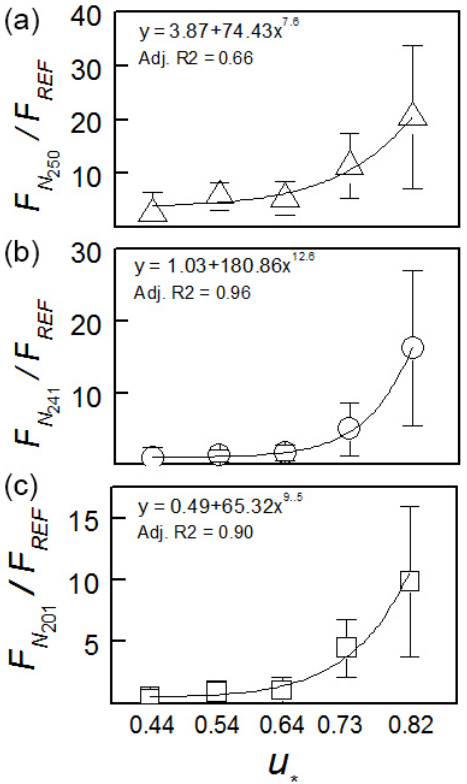
Figure 5. Dust emissions ratio dependency on friction velocity and livestock density. Open triangles ( (cid:52) ), circles ( ◦ ), and squares ( (cid:3) ) denote dust emissions values from the trampled surfaces with live- stock densities of 250, 241, and 201headha − 1 , respectively. (a) Re- lationships between the mean emissions ratio ( F N /F REF ) and u ∗ for N values of 201, 241, and 250headha − 1